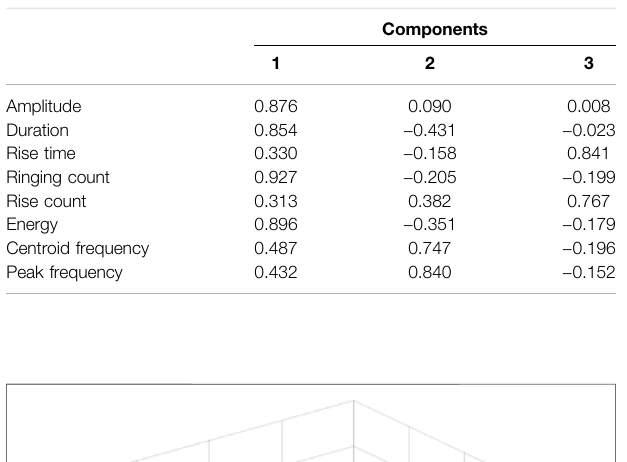
FIGURE 9 | Damage mode classi fi cation diagram of sample